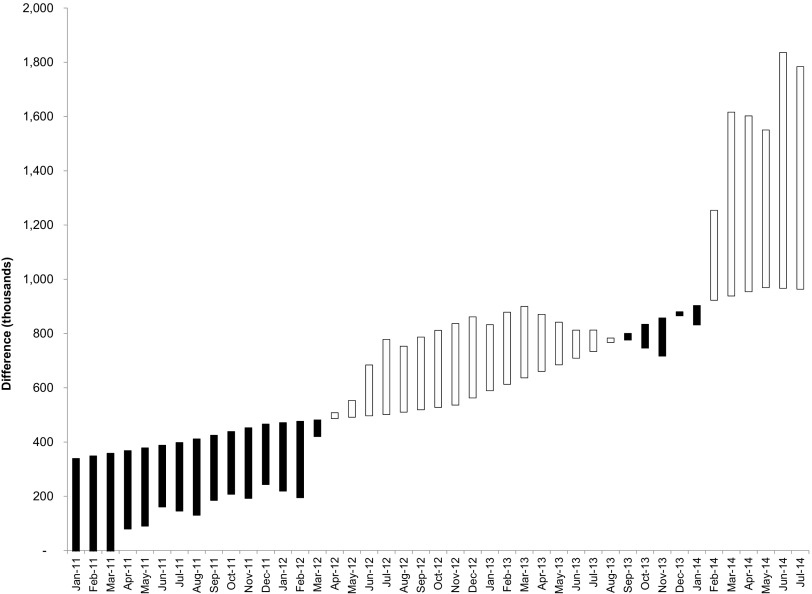
Deficit and Surplus of System Imputed Inventory Compared With System Inventory Filled to MaxWhite bars represent surplus; black bars represent deficit.